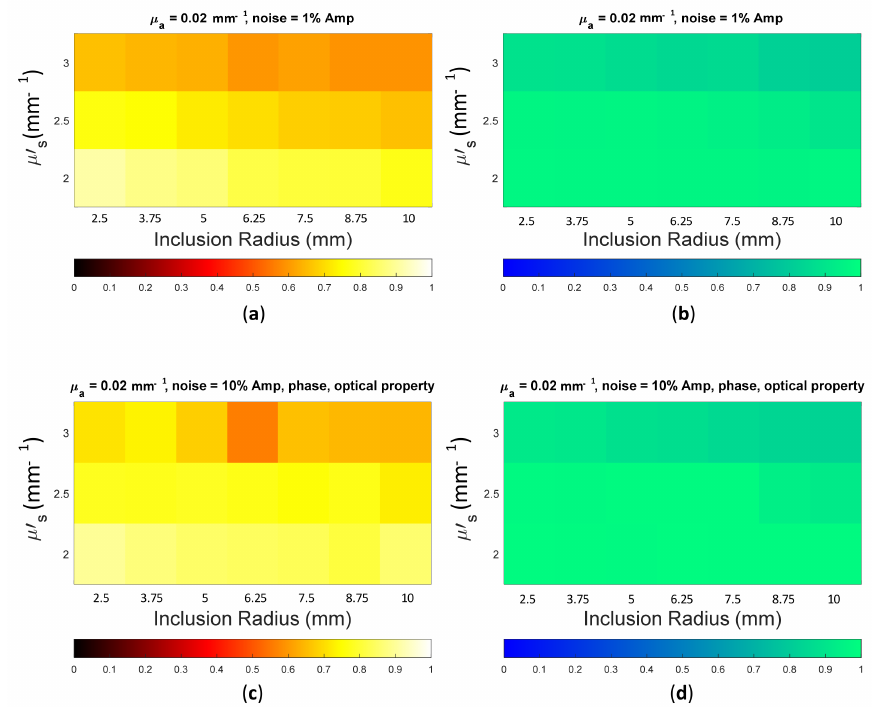
Figure 21. Color map of the MS-ISSIM-S score for ( a ) Figure 17a; ( b ) Figure 17c; ( c ) Figure 18a; and ( d ) Figure